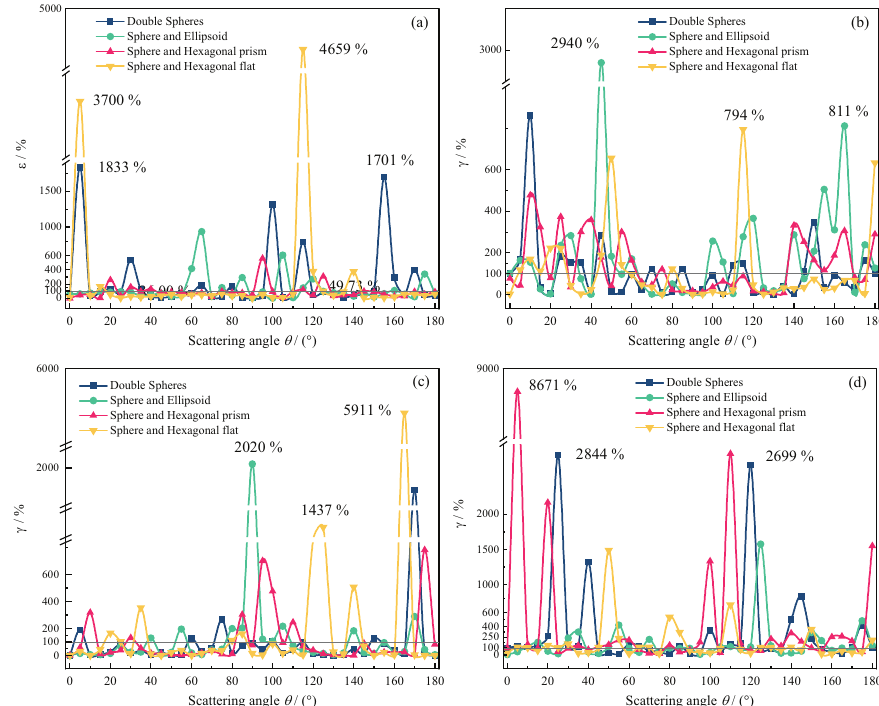
(cid:1) Figure 9. The relative errors of the Mueller matrix elements of ice crystal particles at Θ = 0 ◦ and Θ = 90 ◦ .